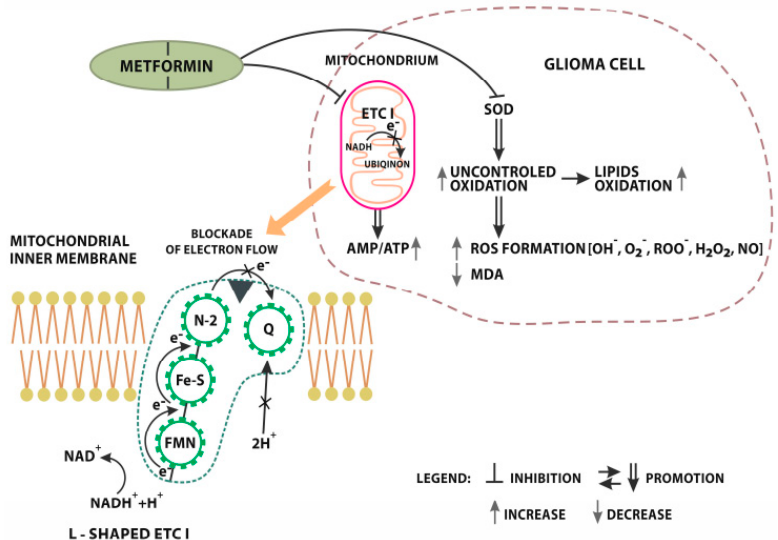
Figure 1. Metformin AMPK independent signaling. Inhibition of L-shaped electron transport chain complex I (ETC I) localized on mitochondrial inner membrane. NADH + H transfer electrons to FMN (flavin mononucleotide) preluding further reduction to FMNH2). In the next step, electrons move along iron-sulfur groups to N2 (Iron sulphur protein) where ETC1 uses this electrical work to pump H+ ions out of the matrix. Electrons are finally delivered from the Iron sulfur complex to Q (Ubiquinone). After the acceptance of electrons, ubiquinone uptakes two protons from the matrix. The whole process is finished with a full transformation into a reduced form of ubiquinol-quinol QH2. Metformin blocks electron flow from the Iron sulphur complex to ubiqinon. This blockade results in significant reduction of proton pomp efficiency and the growth of the AMP/ATP ratio. Metformin influences oxidation processes. MET directly limits SOD (Superoxide dismutase) activity. Inhibition of SOD precedes the uncontrolled oxidation of lipids and excessive ROS (Radical Oxygen Species) formation [OH − -hydroxyl radical, O 2 − -superoxide anion, ROO-peroxyl radical, H 2 O 2 hydrogenperoxide , NO nitric oxide.].